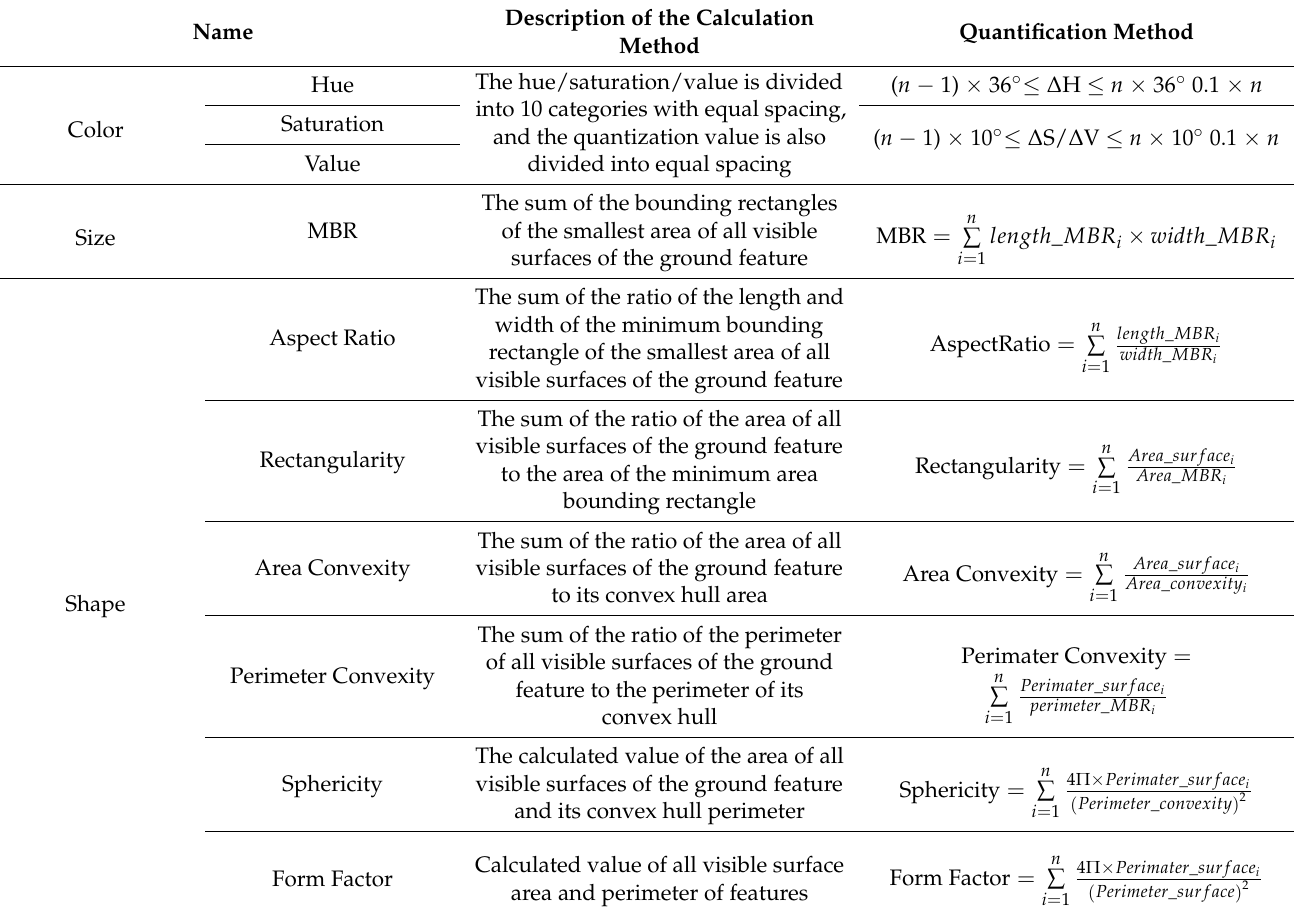
Table 2. Visual saliency impact factor parameters and their quantification